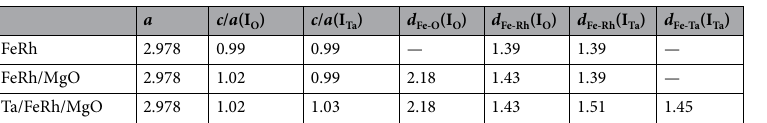
Table 1. Values of the c / a ratio and the interlayer distances ( d in Å) at the interfaces for FeRh in the most stable AFM, FeRh/MgO in the AFM(I Ta denote the interfaces next to the MgO and Ta layers, respectively. The same in-plane lattice ( a ) of 2.978 Å was employed for each